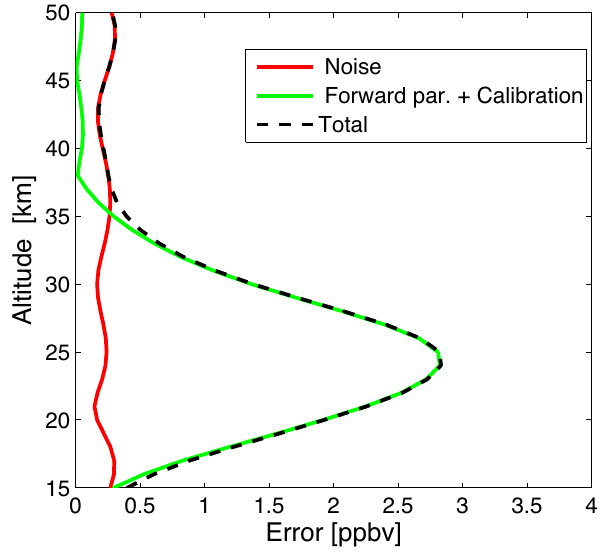
Fig. 4. Estimated errors on the retrieved Antarctic fall profile pre- sented in Fig. 5. The various sources of error are: calibration and forward parameters (green line) and measurement noise (red line). The total uncertainty is also shown (dashed black